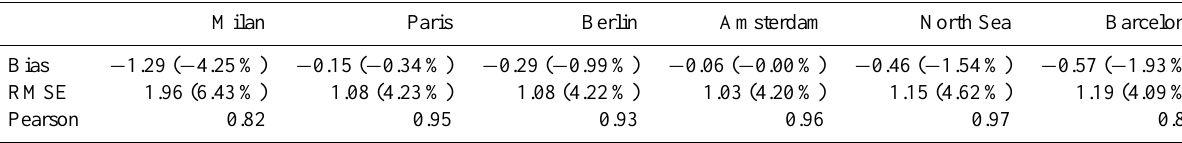
Table 6. Mean biases, RMSEs and Pearson correlation coefficients of MAGEAQ-TIR surface–6km TOC pseudo-observations, with respect to MOCAGE pseudo-reality, at six selected locations. Results are reported for Milan, Paris, Berlin, Amsterdam, the marine location west of Norway’s coast, and Barcelona. Percent values of biases and RMSEs are reported in parentheses.